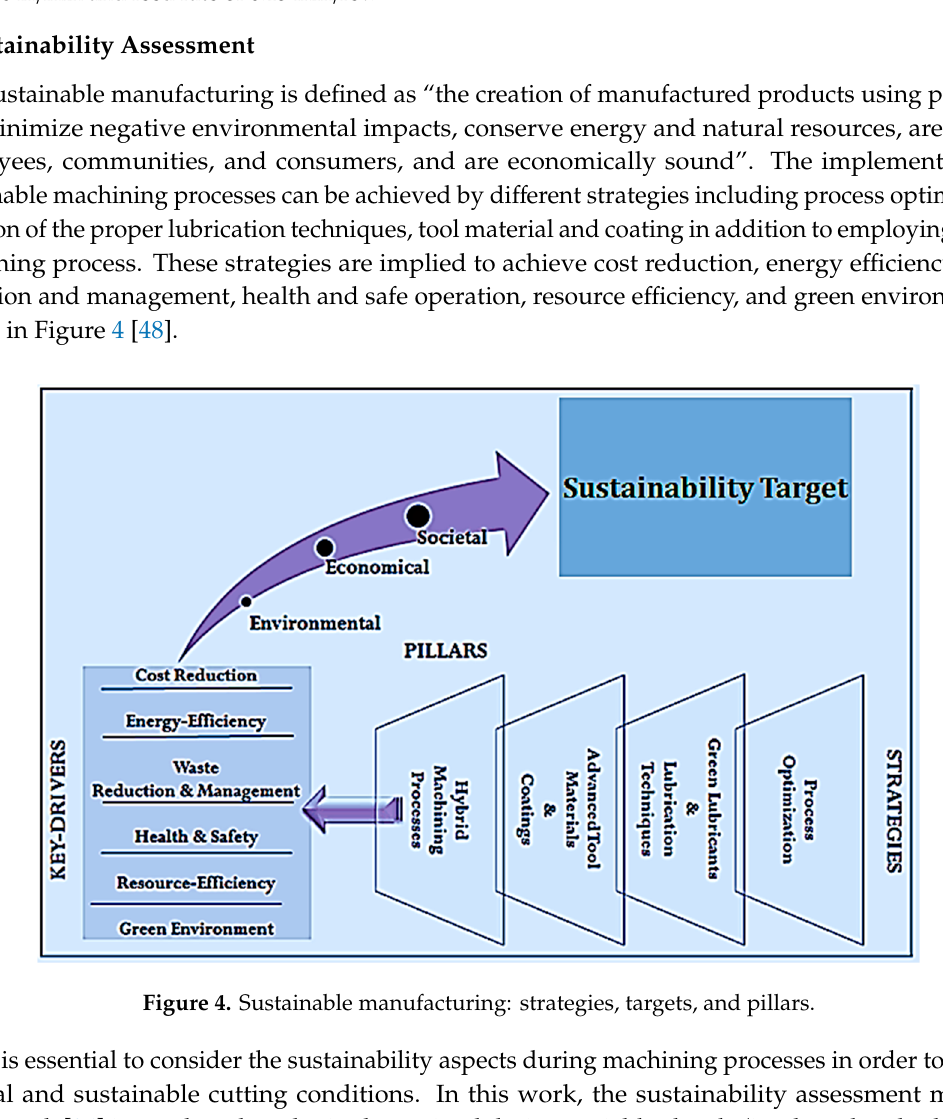
Figure 3. Tool wear mechanisms with MQL nanofluid ( a ) with classical MQL ( b ) at a cutting speed of 170 m/min and feed rate of 0.15 mm/rev .